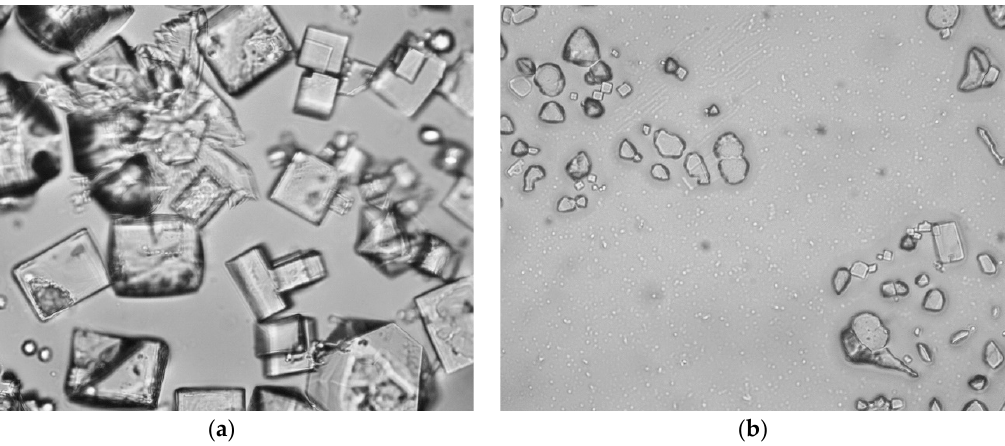
Figure A5. Trial RT1: Transmitted light photomicrographs of evaporated water: ( a ) seawater (ISE = 40.1 g NaCl L − 1 evaporation = 44.21 g L − 1 ); ( b ) product water (ISE = 8.33 g NaCl L − 1 ; evaporation = 4.21 g NaCl L − 1 ). The crystals are NaCl. Field of view = 1.6 mm.